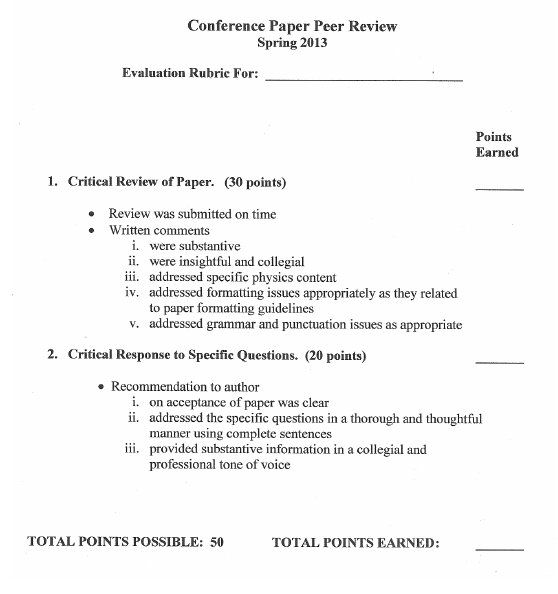
Figure 4. Assessment rubric for the peer